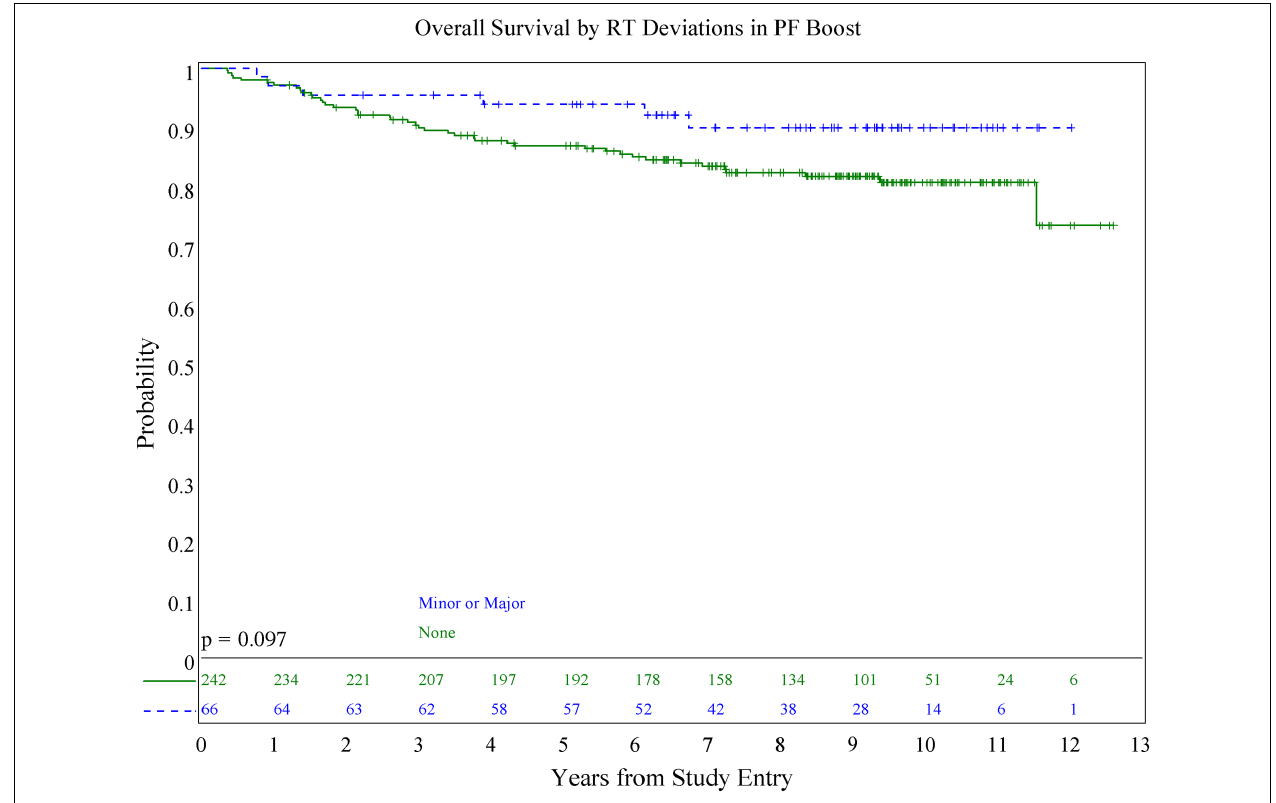
FIGURE 7 |Association of posterior fossa deviations and overall